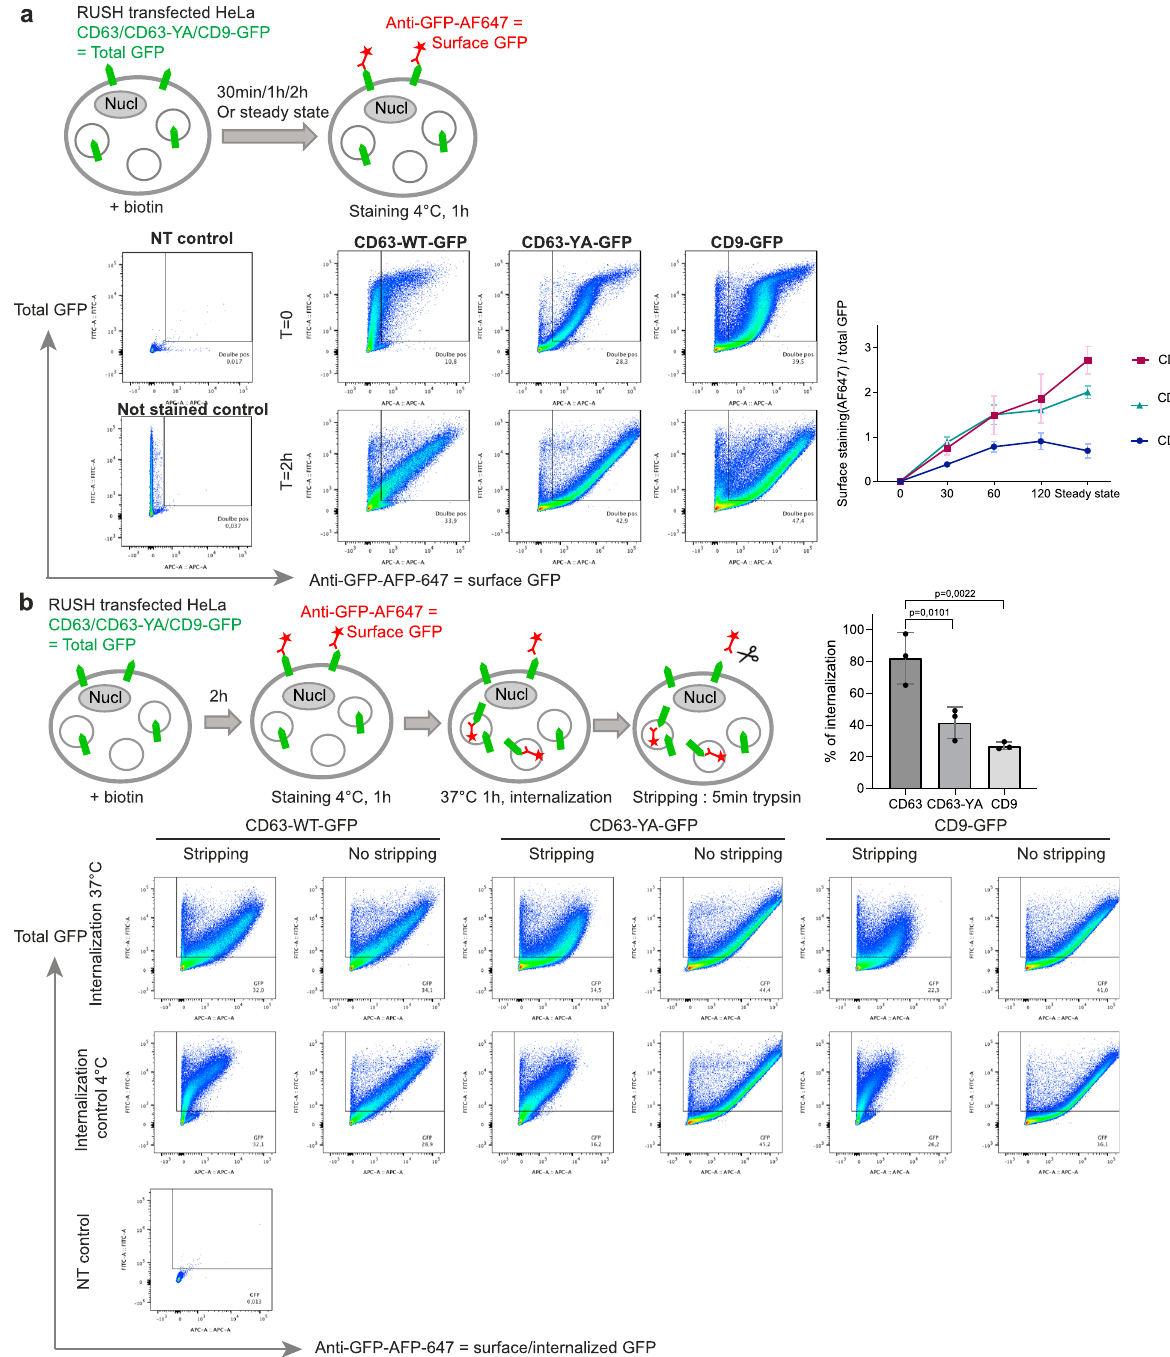
Fig. 4 Dynamics of localization at the plasma membrane and of internalization of CD63 are different from those of CD63-YA and CD9. a Principle and fl ow cytometry analysis of anti-GFP surface staining of HeLa cells transfected with the RUSH constructs CD63-WT-eGFP , CD63-YA-eGFP , or CD9-eGFP after different incubation times with biotin followed by fi xation. The ratio of the surface staining (AF647) over the total GFP signal mean fl uorescence intensities is represented at different time points, time 0 subtracted, mean ± SD for 3 independent experiments. b Principle and fl ow cytometry analysis of anti-GFP uptake after surface staining of HeLa cells transfected with the RUSH constructs CD63-WT-eGFP , CD63-YA-eGFP , or CD9-eGFP after 2 h of incubation with biotin. The mean percentage ± SD of internalized anti-GFP-AFP647 is represented for 3 independent experiments. Ordinary one-way ANOVA, Tukey ’ s multiple comparisons test. Gating strategy is illustrated in Supplementary Fig.